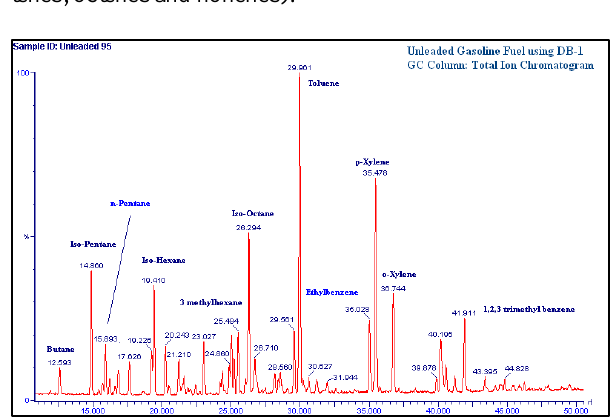
Fig. 2. GC-MS characterisation of the components in used commercial gasoline